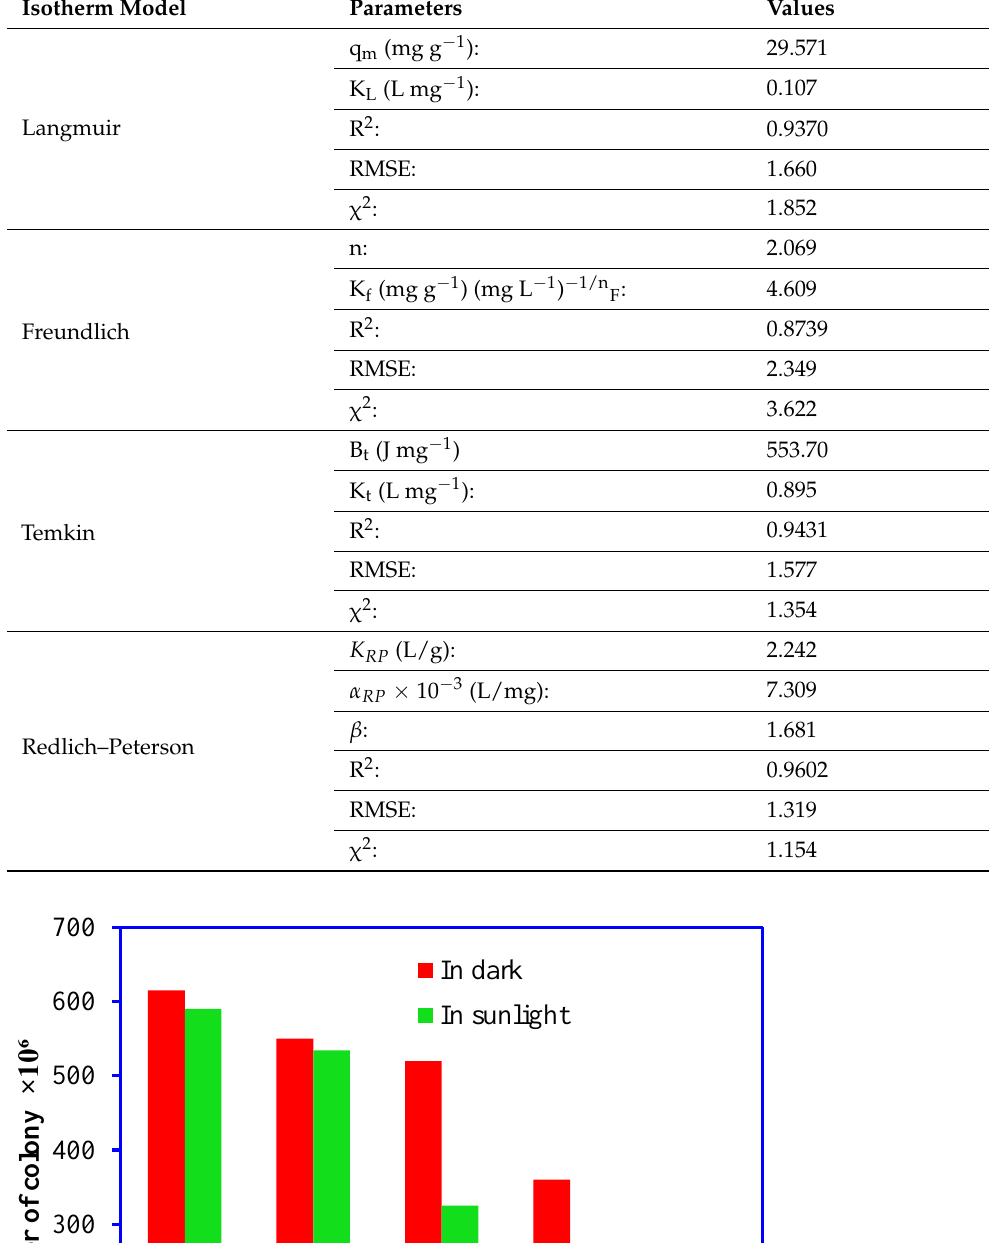
Table 2. The values of adsorption isotherm parameters for OTC onto Ni 3 S 4 /Ag 2 S/TiO 2 /CA aerogel.